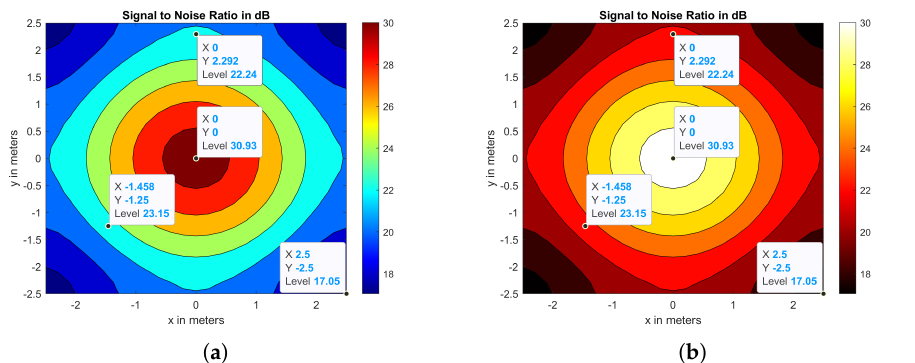
Figure 10. Reciprocity Principle: SNR distributions for DL and UL connections. Table 6. Uplink performance of CLQ and CoIQ for given room dimensions CLQ Proposed CoIQ Deviation in SNR